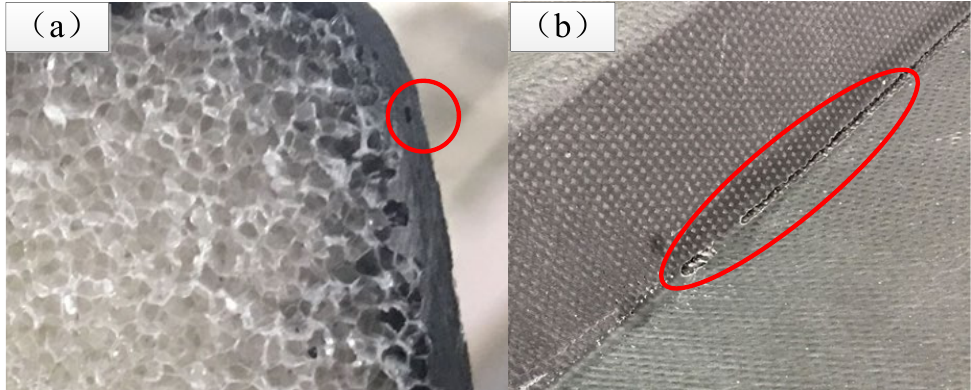
Figure 13. Manufacturing defects in Case 2. ( a ) Interlayer pores; ( b ) lack of resin in